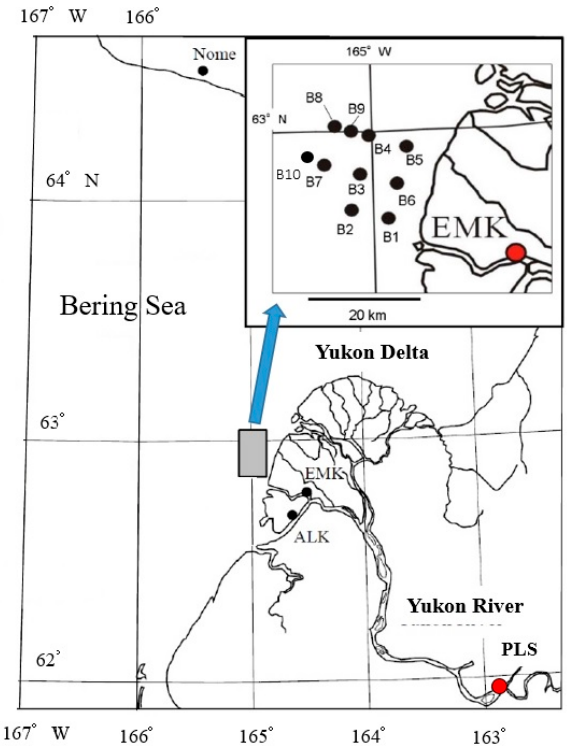
Figure 1. Location of ten observation sites off the Yukon delta front. The label “PLS” shows the location of the lowest USGS (U.S. Geological Survey) gauging station in the Yukon River.